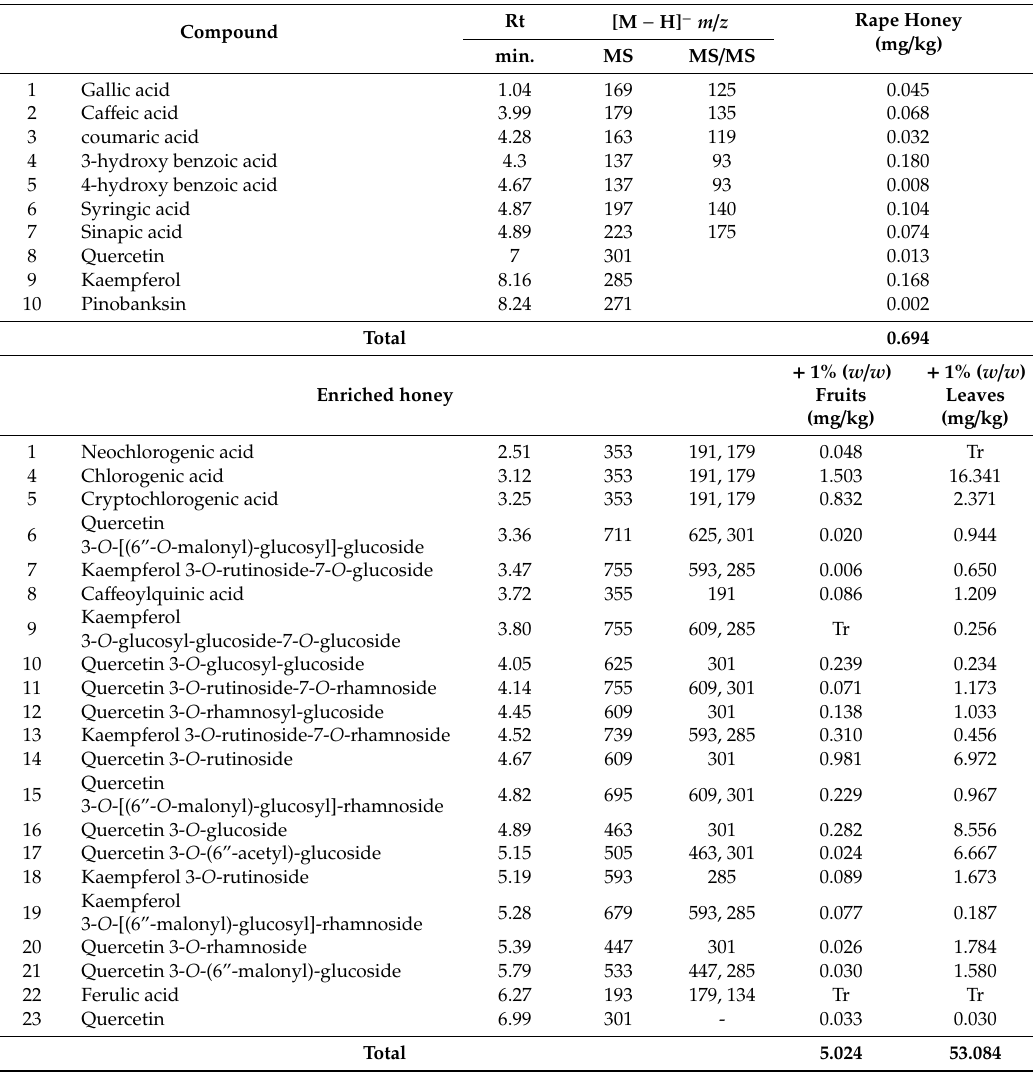
Table 6. E ff ect of addition of leaves or fruits mulberry (1% w / v ) on the phenolic profile of rape